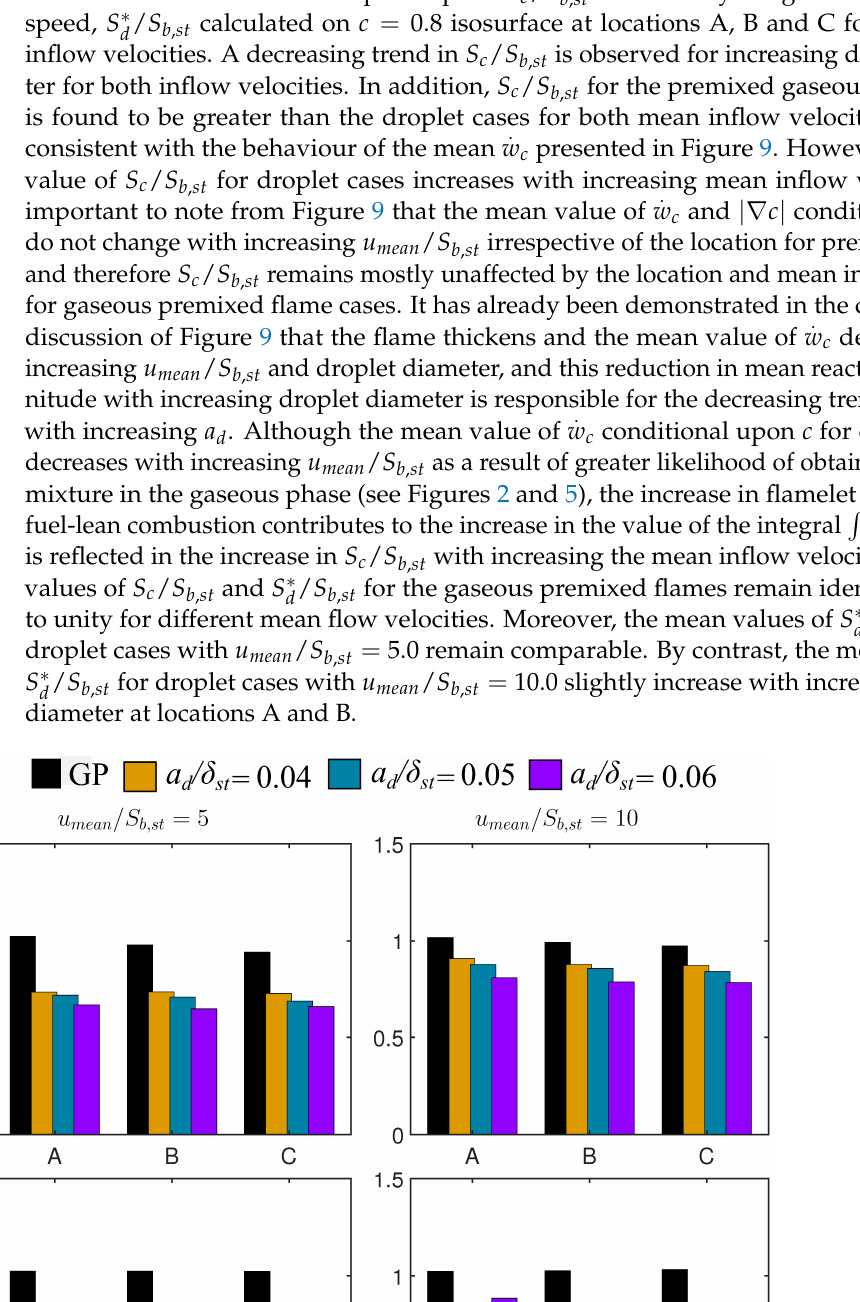
on the 𝑐 = 0.8 isosurface at locations A–C for the cases with / S b ( (cid:104) φ on the c = 0.8 isosurface at locations A–C for the cases with (cid:3282) 〉) d g (cid:105) )